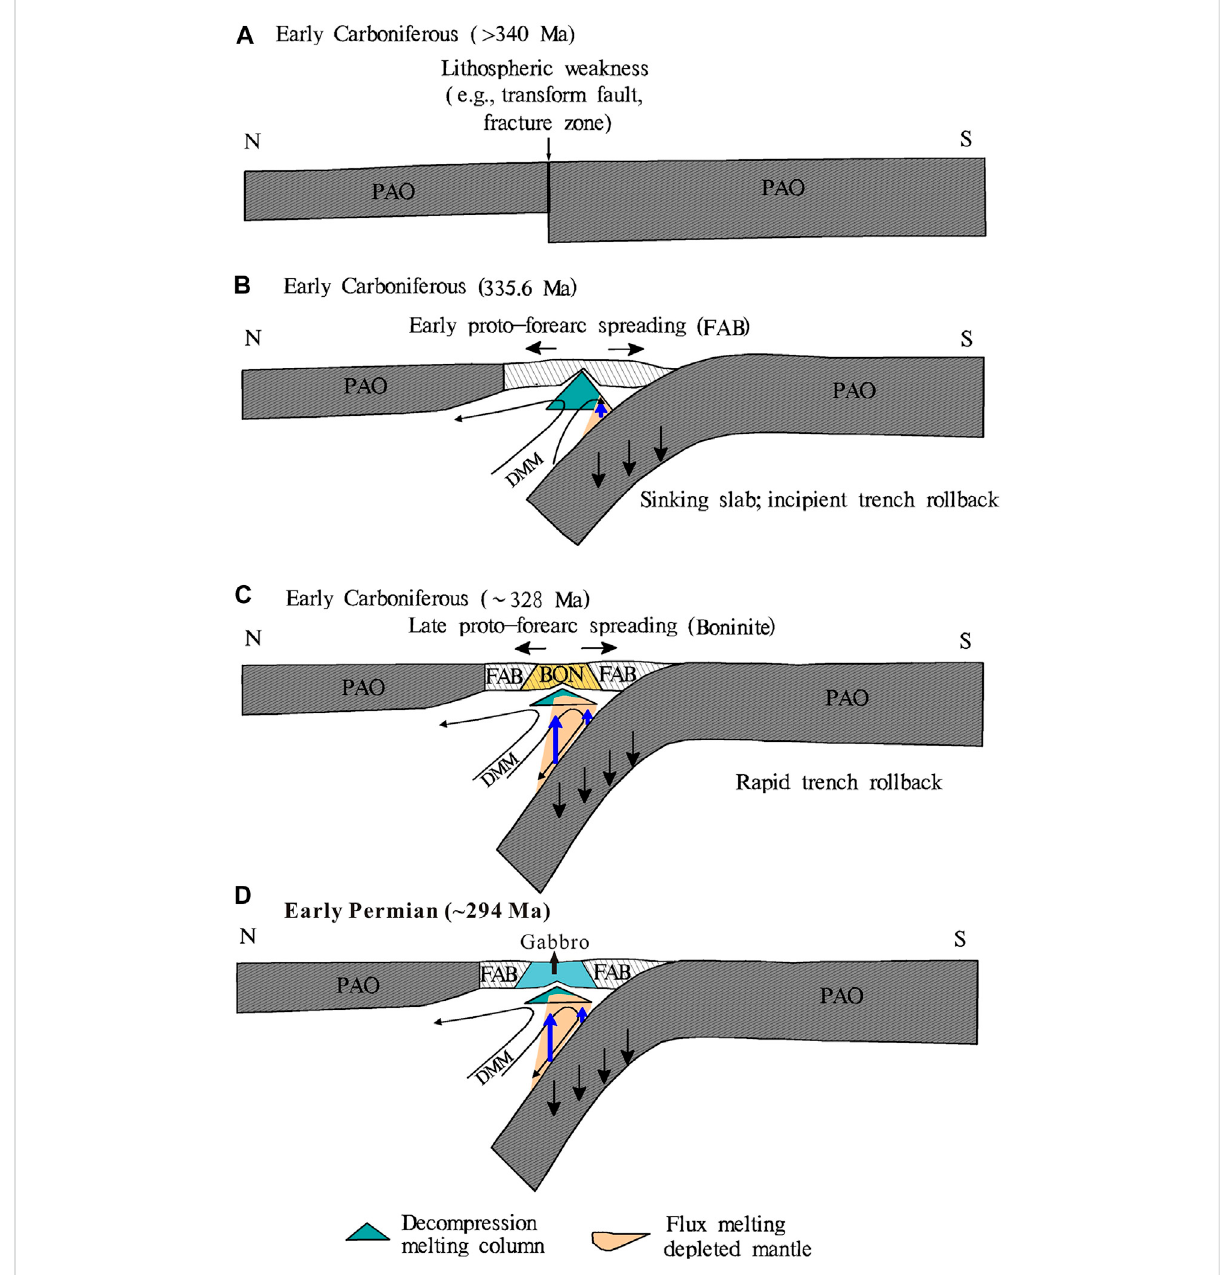
FIGURE 8 Evolution of the Early Carboniferous Diyanmiao intra-oceanic forearc system in the central Inner Mongolia, N China, as a typical example of subduction initiation of the southeastern PAO, based on the subduction infancy model (Whattam and Stern, 2011; Reagan et al., 2017). (A) Oceanic crustboundaryprecedingsubductioninitiation. (B) EarlyCarboniferoussubductioninitiation,leadingtoforearcspreadingandformationofFABs. (C) As the subduction initiation process continued, boninites and transitional lavas were formed. (D) As the subduction process continued, the gabbro were formed. DMM is depleted MORB